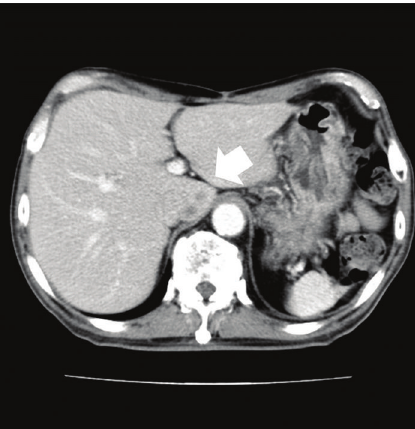
Figure 5: Enhanced computed tomography (CT) of the abdomen. The tumor was detected in the Spiegel of the liver on enhanced CT of the abdomen (arrow).